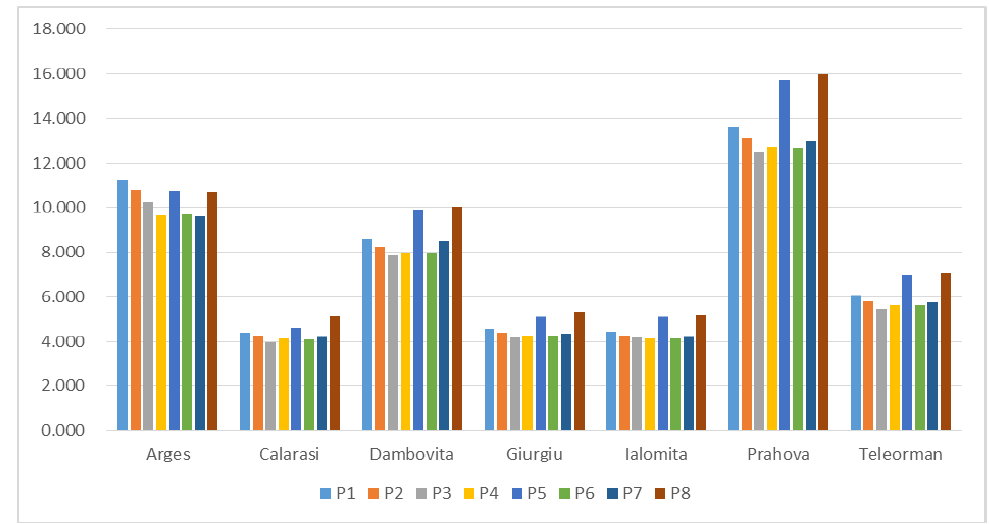
Figure 12. LCC at county level for the maximum scenario (bln.euro).